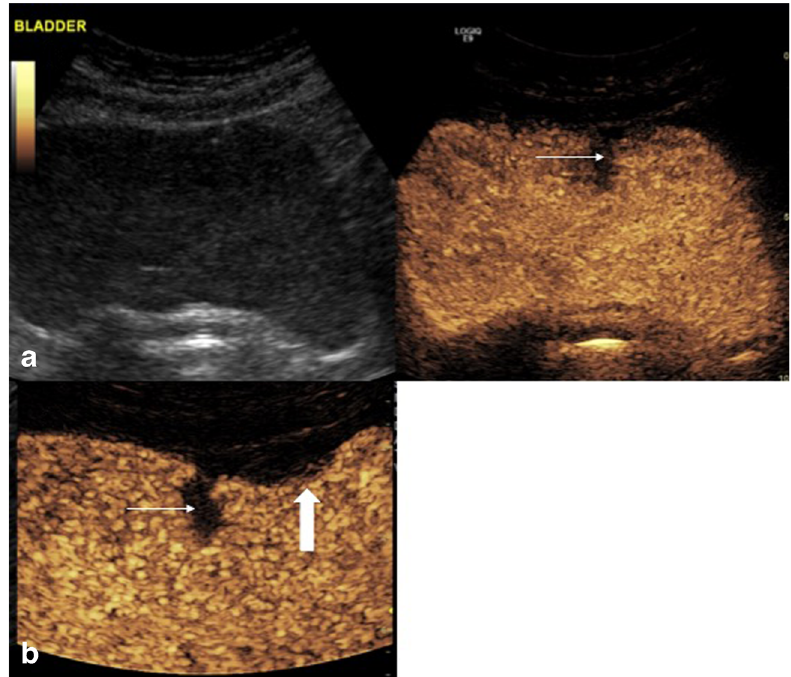
moieties (arrows) of the right kidney retrogradely. There is significant dilation of the renal pelvis and blunting of the renal calyces. These findings are in keeping with grade 3 reflux. (Image courtesy of Dr. Susan Back, Philidelphia, PA,